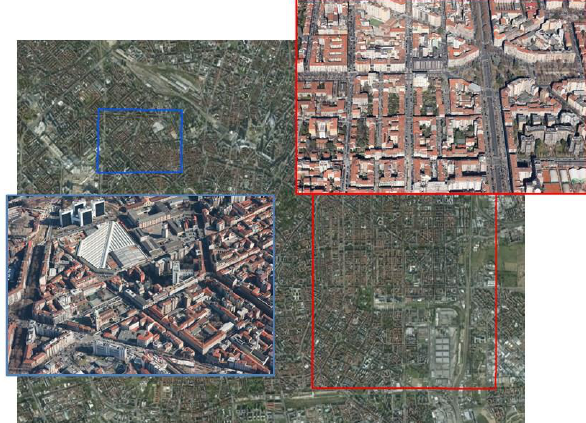
Figure 8. The first (red rectangles) and the second (blue rectangles) test areas over the city of Milano